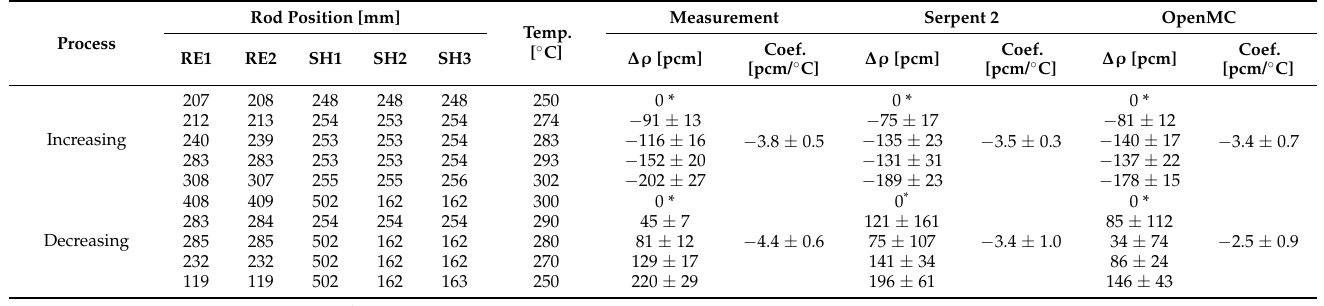
Table 7. Results of temperature coefficient.